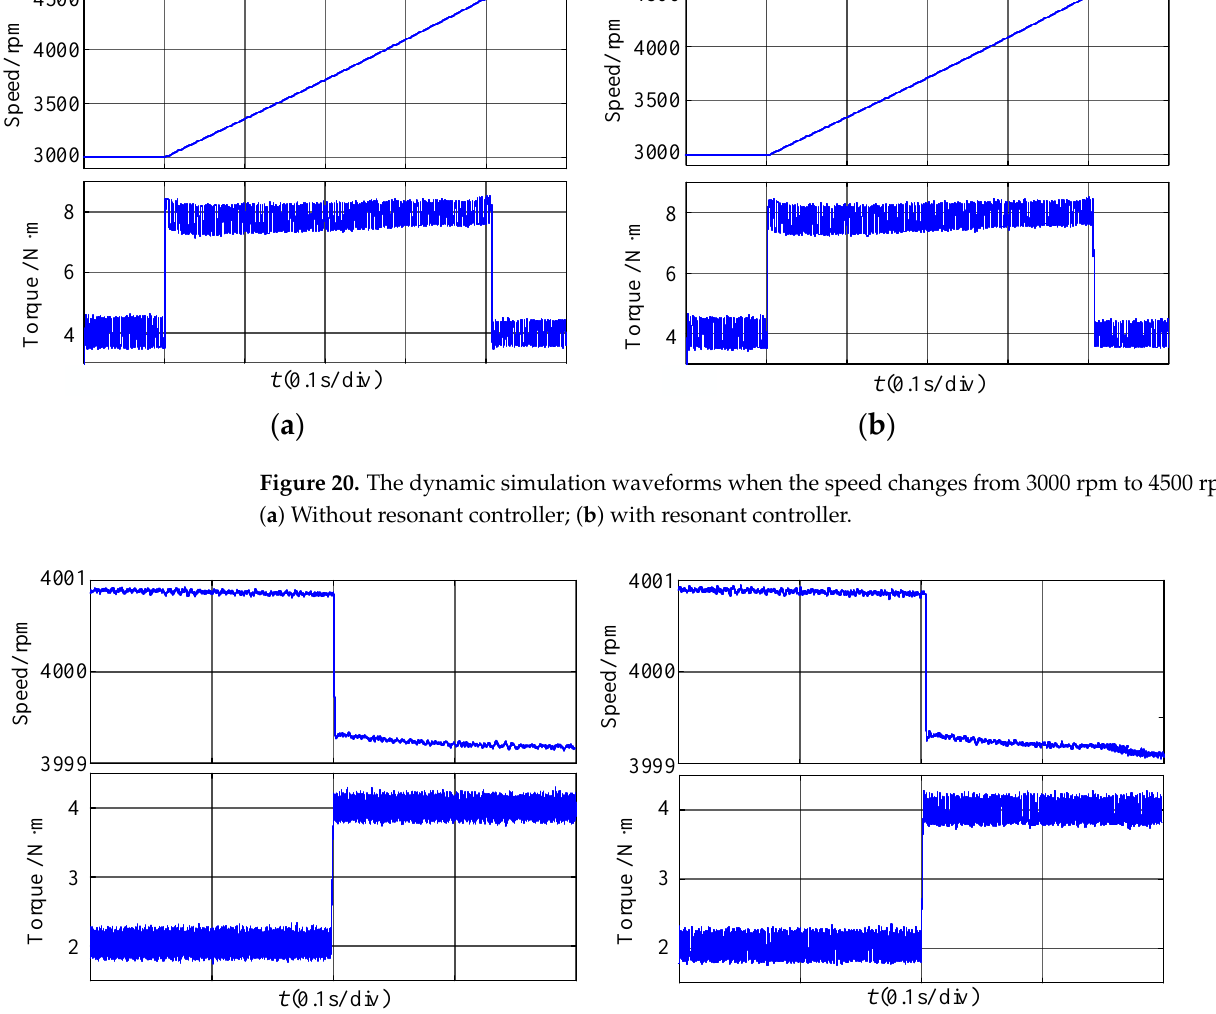
Figure 21. The dynamic simulation waveforms when the load changes from 2 N·m to 4 N·m. ( a )